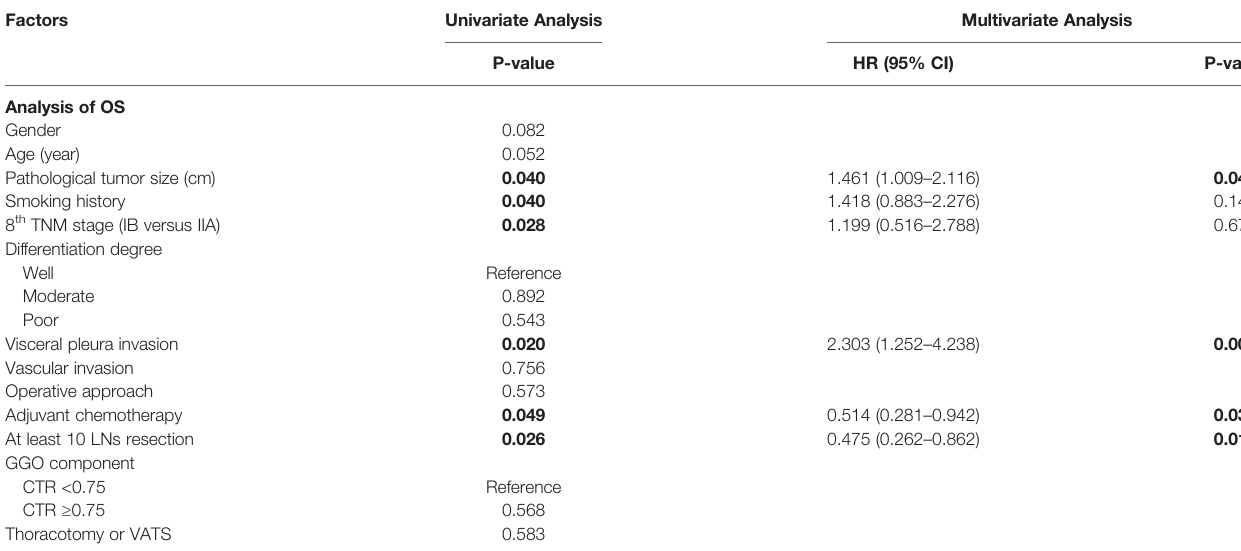
TABLE 3 | Univariate and multivariate analyses for patients with risk score ≥